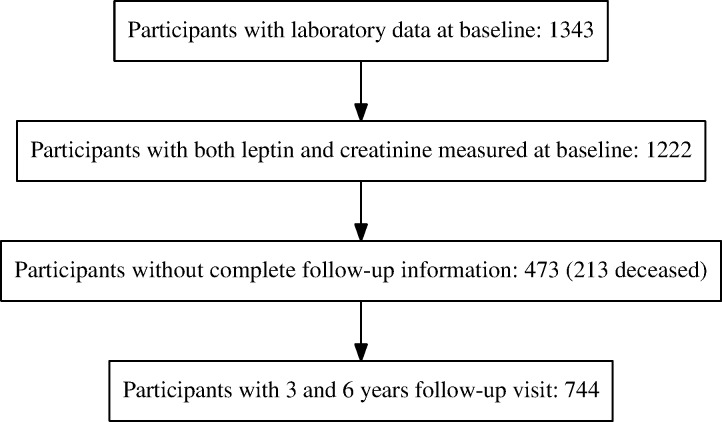
CONSORT diagram of the study.